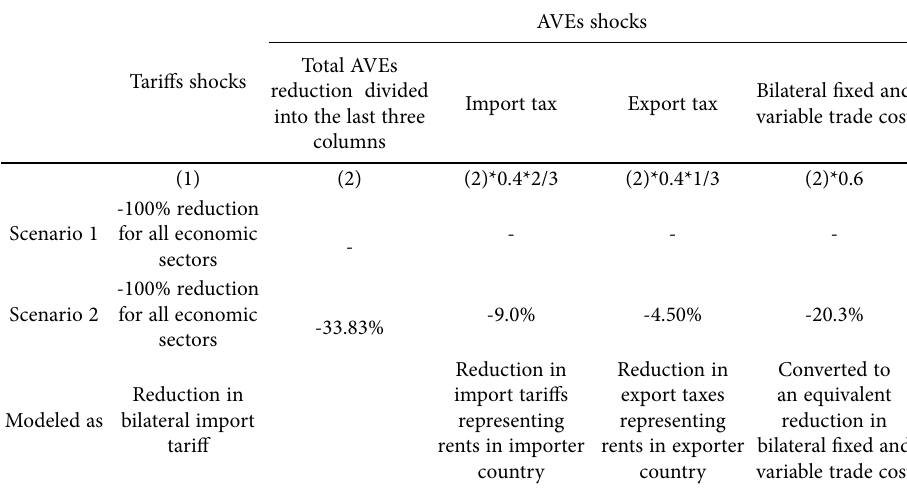
Table 1. Scenario